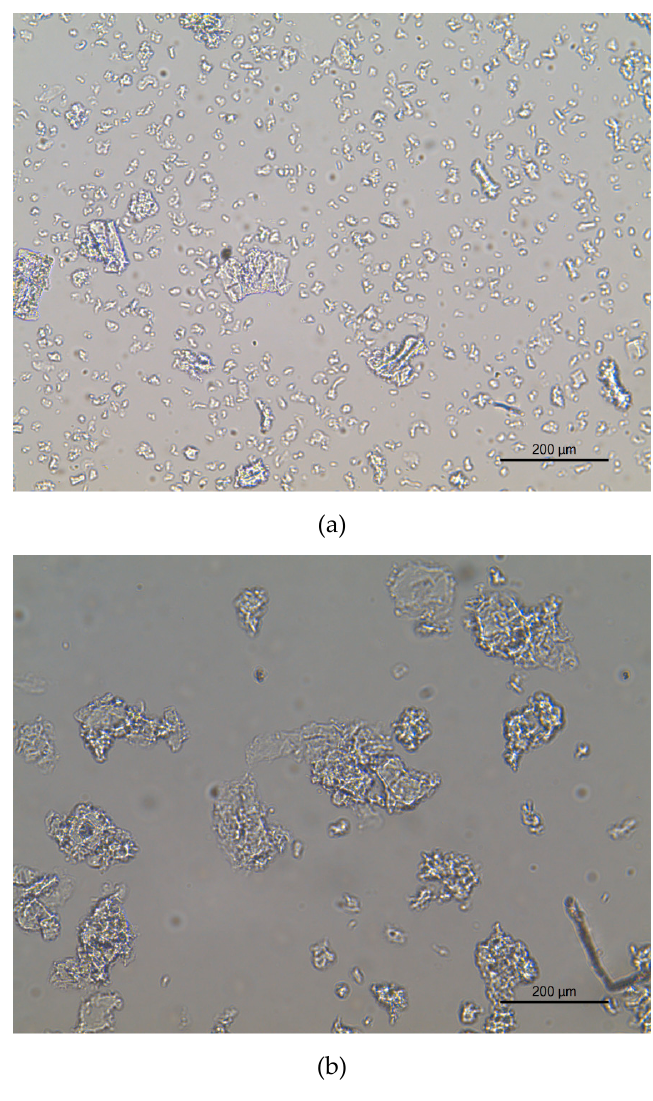
Table 3. Dimensions of dicarboxymethyl